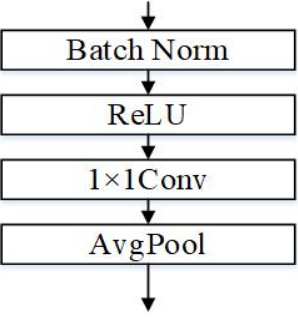
Figure 4. Transition architecture.